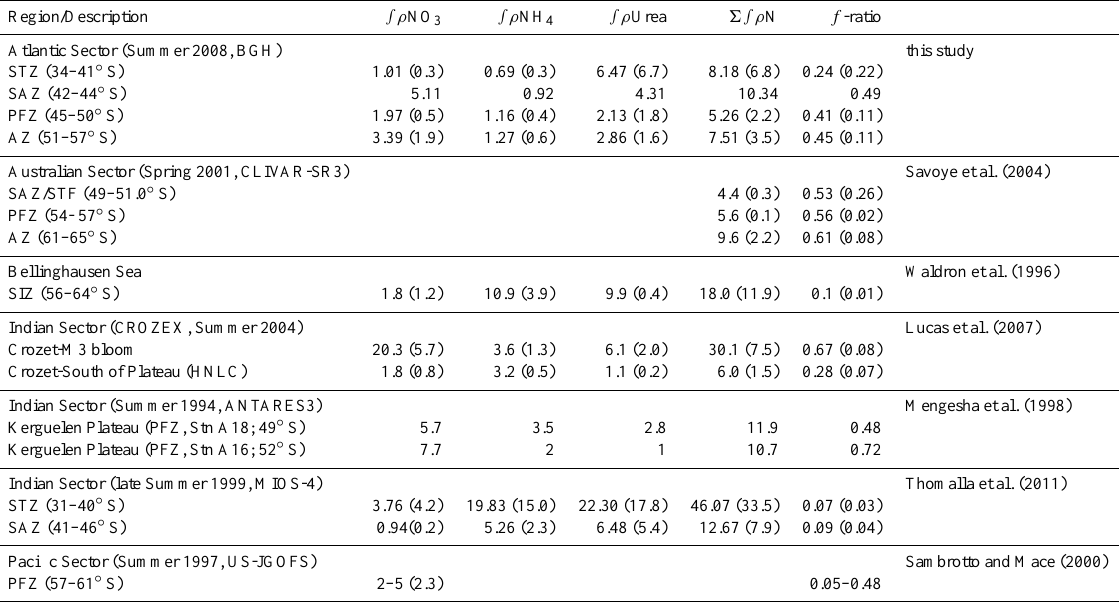
Table 3. Comparison of depth integrated values of 15 N uptake (mmolm − 2 d − 1 ) by phytoplankton in various regions of the Southern